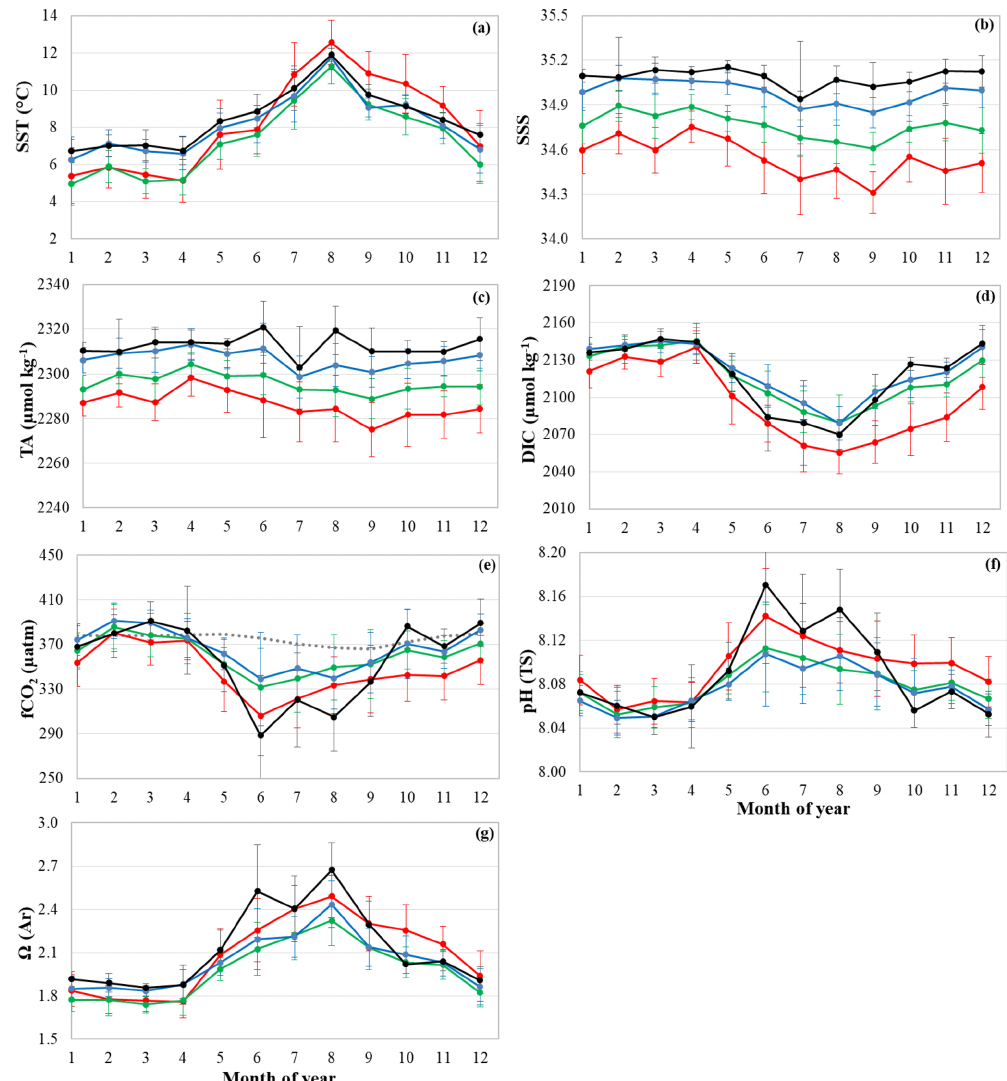
Figure 2. Mean seasonal cycle of (a) SST, (b) SSS, (c) TA, (d) DIC, (e) f CO 2 , (f) pH and (g) (cid:127) (Ar) over the period 1993–2017 in boxes B, C, D and E identified with corresponding colors in Fig. 1. Mean seasonal cycle of atmospheric f CO 2 from Mace Head station is represented by grey dots in (e) . Errors bars result from both interannual and spatial variability within a